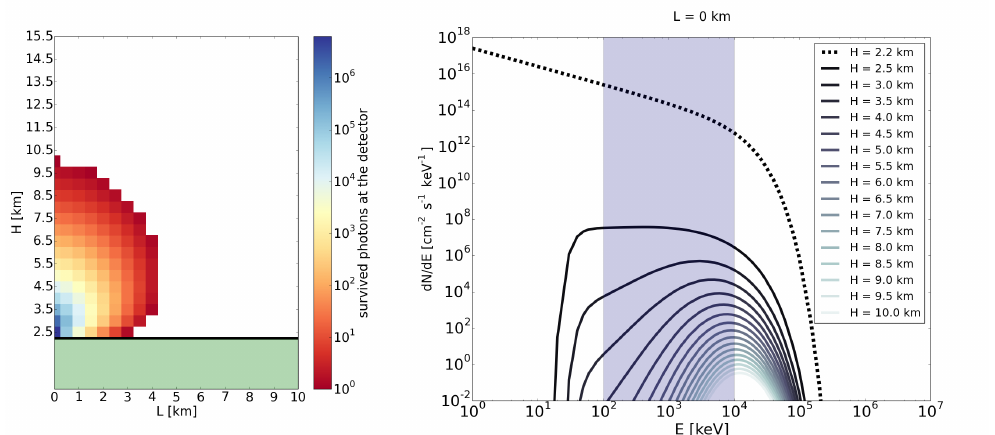
Figure 8. Left : detectability region obtained from the analytical model, for N 0 = 10 18 initial gamma- ray photons and emission half-angle α = 40 ◦ . TGF events occurring within this set of ( L , H ) values shall be detected on ground, by the mountain-based Gamma-Flash detection system. Right : spectra of the survived gamma-ray photons at the detector for different production altitudes H (here, only displayed for L = 0.0 km). The blue shaded region indicates the 100 keV–10 MeV energy range considered for the